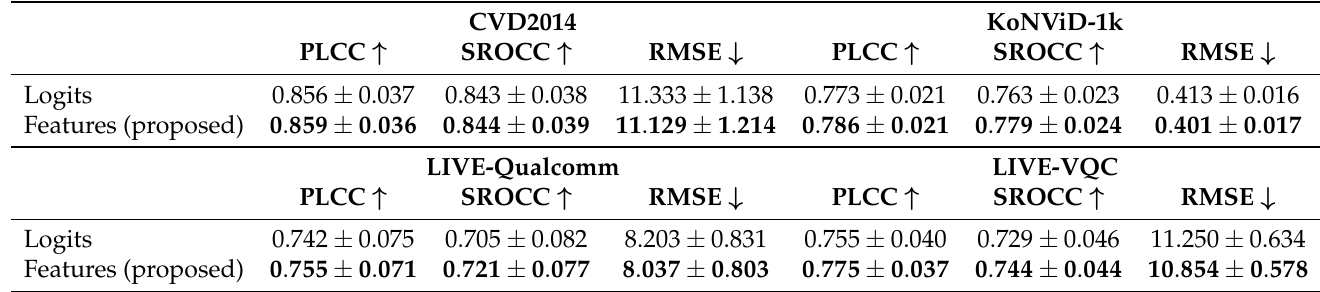
Table 6. Mean PLCC, SROCC, and RMSE across 100 train–test combinations on the four considered databases using the logits or the features obtained from Extractor-Q and Extractor-S. In each column, the best and second-best values are marked in boldface